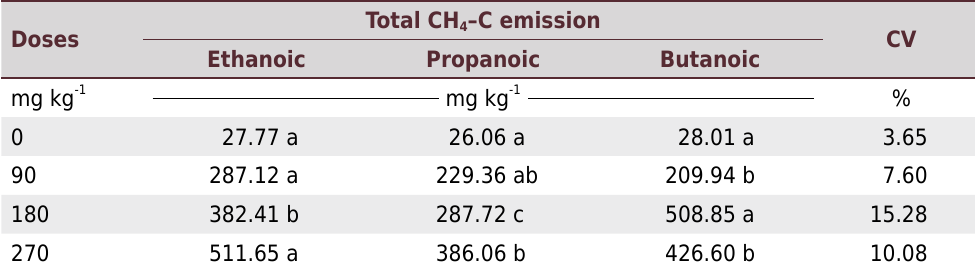
Table 2. Average values (n = 36) obtained for the emission of total CH 4 , after application of different short-chain organic acids under controlled laboratory conditions Doses